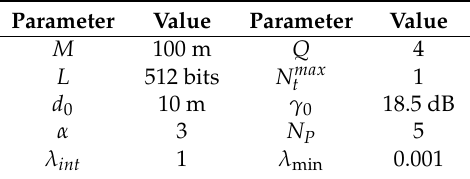
Table 1. Parameters for